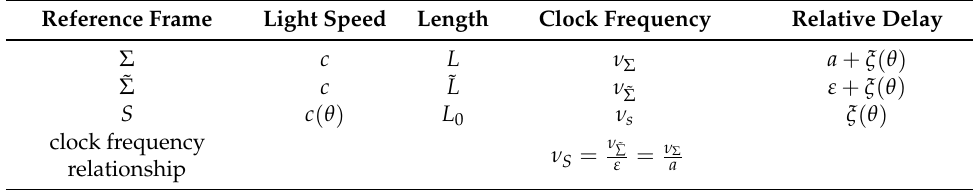
Table 1. The measurements and corrections in each reference